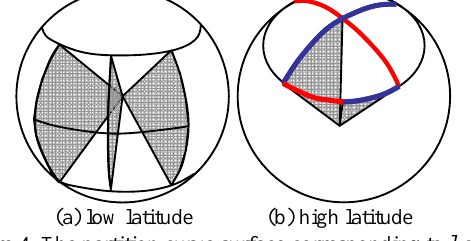
Figure 7. ROS near equator